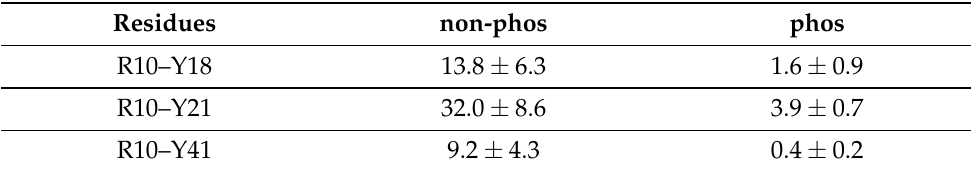
Table 6. Probability of cation– π interaction (%) for certain pairs of residues in non-phosphorylated (non-phos) and phosphorylated (phos) Stath.